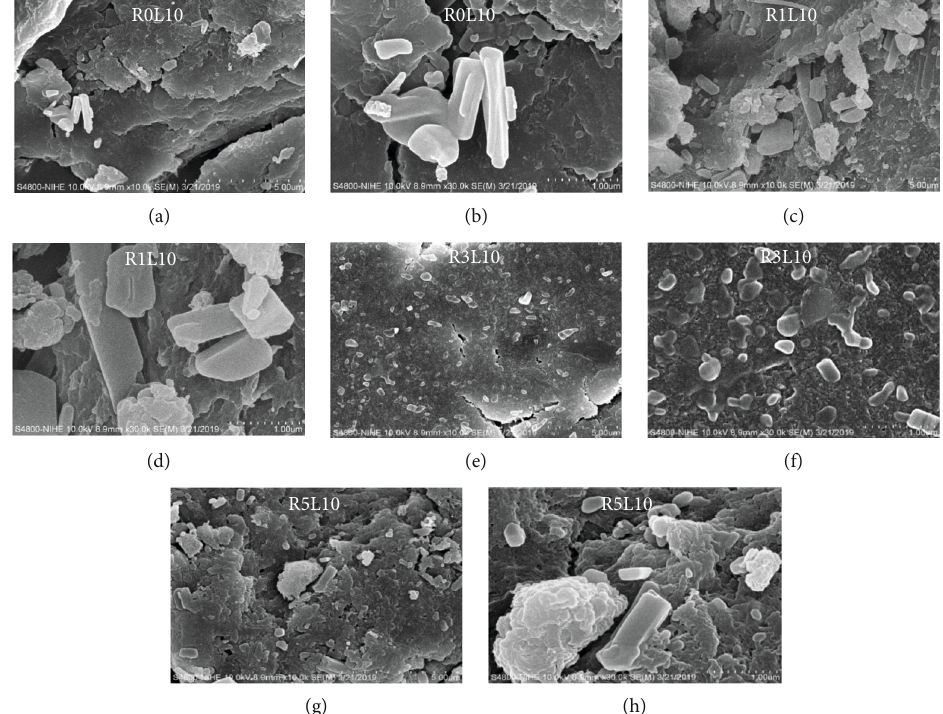
Figure 6: SEM image of AG/CS/Lov particles (without ginsenoside Rb1) — R0L10 sample and NPBs using 1%, 3%, and 5 wt.% ginsenoside Rb1 — R1L10, R3L10, and R5L10 with magni fi cation: × 10,000 (left) and × 30,000 (right).